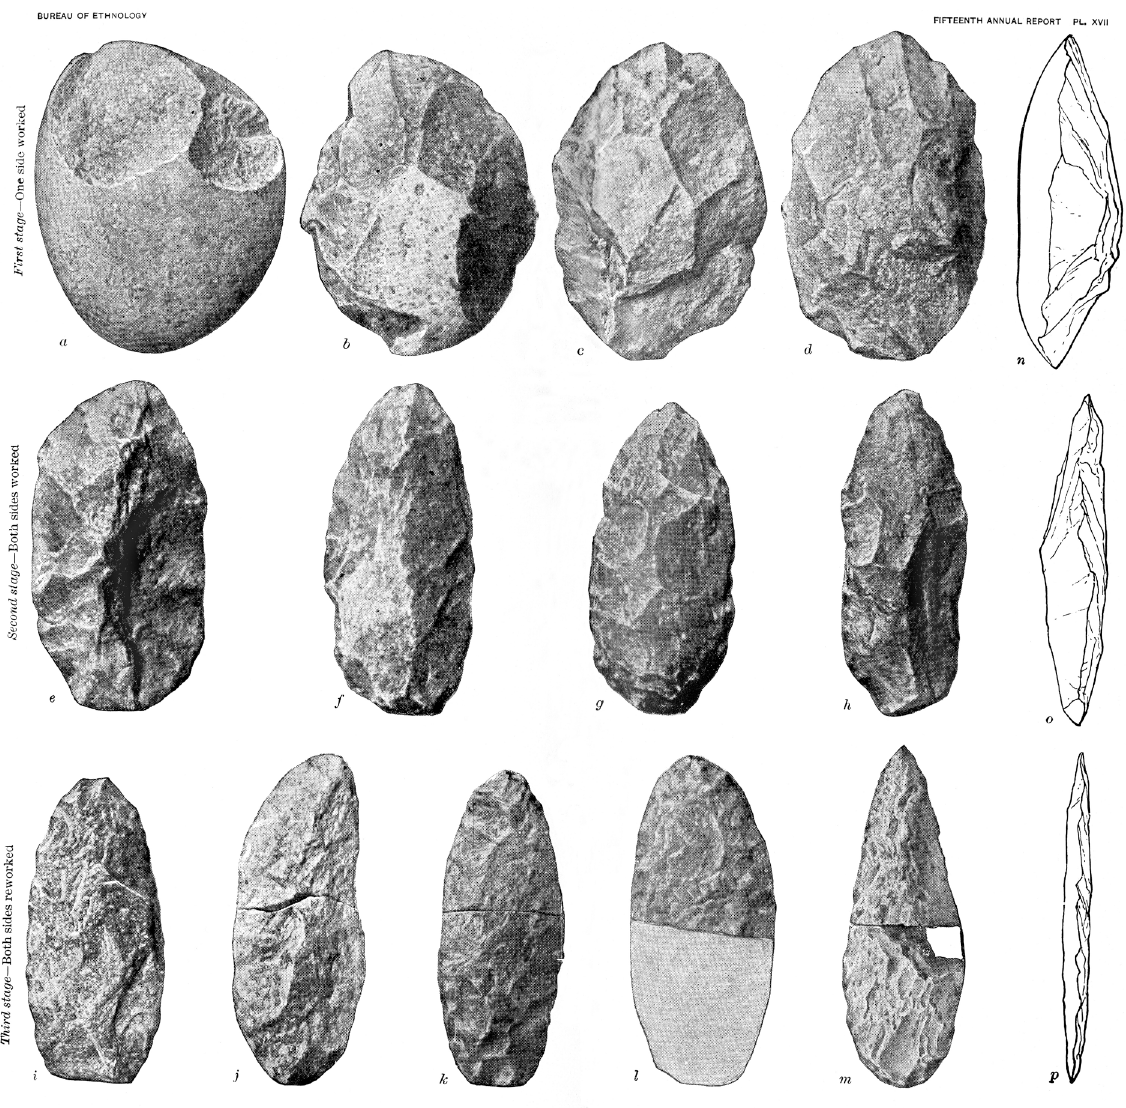
Figure 8. Holmes’ Progressive Series. The cobble at the top left is approximately 11.5 cm in length, and the piece at the lower right is a final-stage preform. After Holmes 1897: plate XVII. [Original caption: Quarry-shop rejects - Progressive Series beginning with the bowlder and ending with the thin